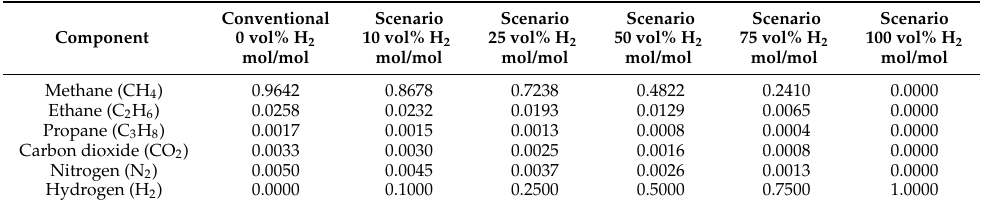
Table 2. Composition of fuel mixtures in the analyzed scenarios. Each composition is given in mole fractions x i (mol/mol fuel). Mole fractions are equivalent to volume fractions ϕ i at standard conditions (STP, 0°C and 1.013 bar). The initial composition of natural gas H from Russia for the conventional scenario is adapted from [37].